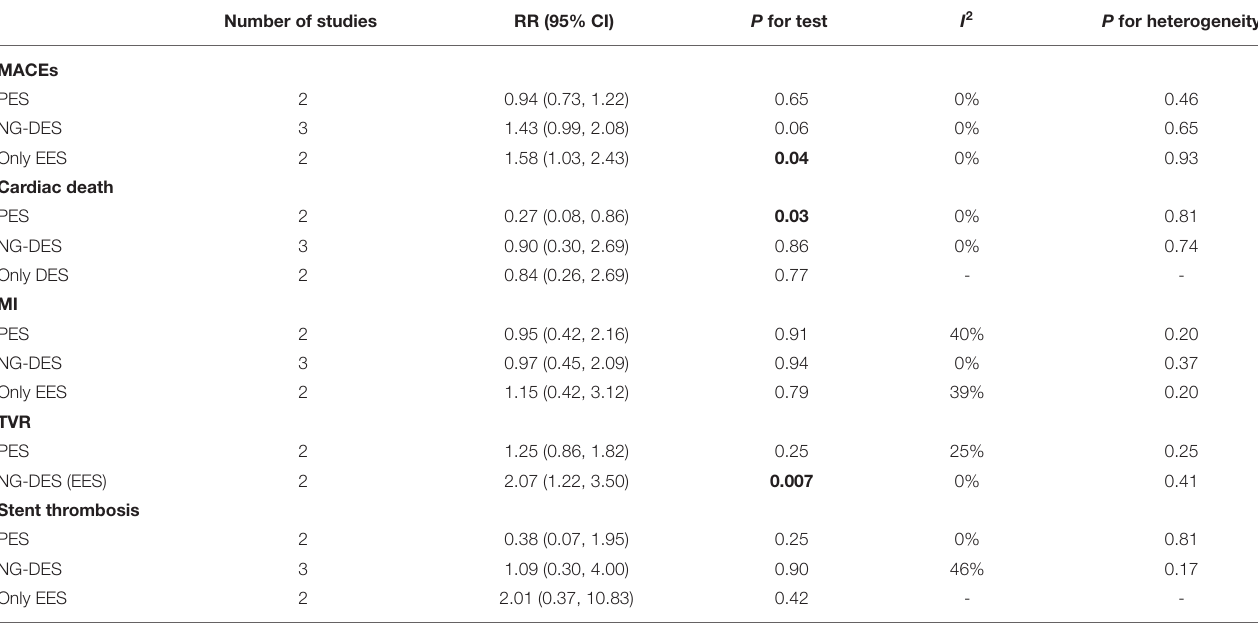
TABLE 4 | Subgroup analysis for secondary